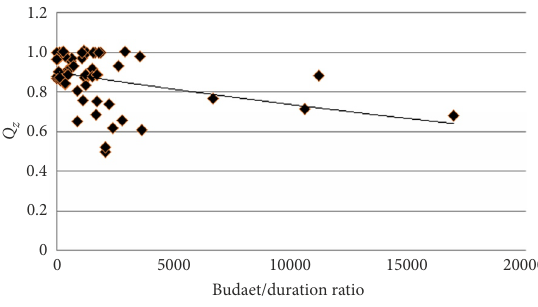
Figure 3. Effect of environmental